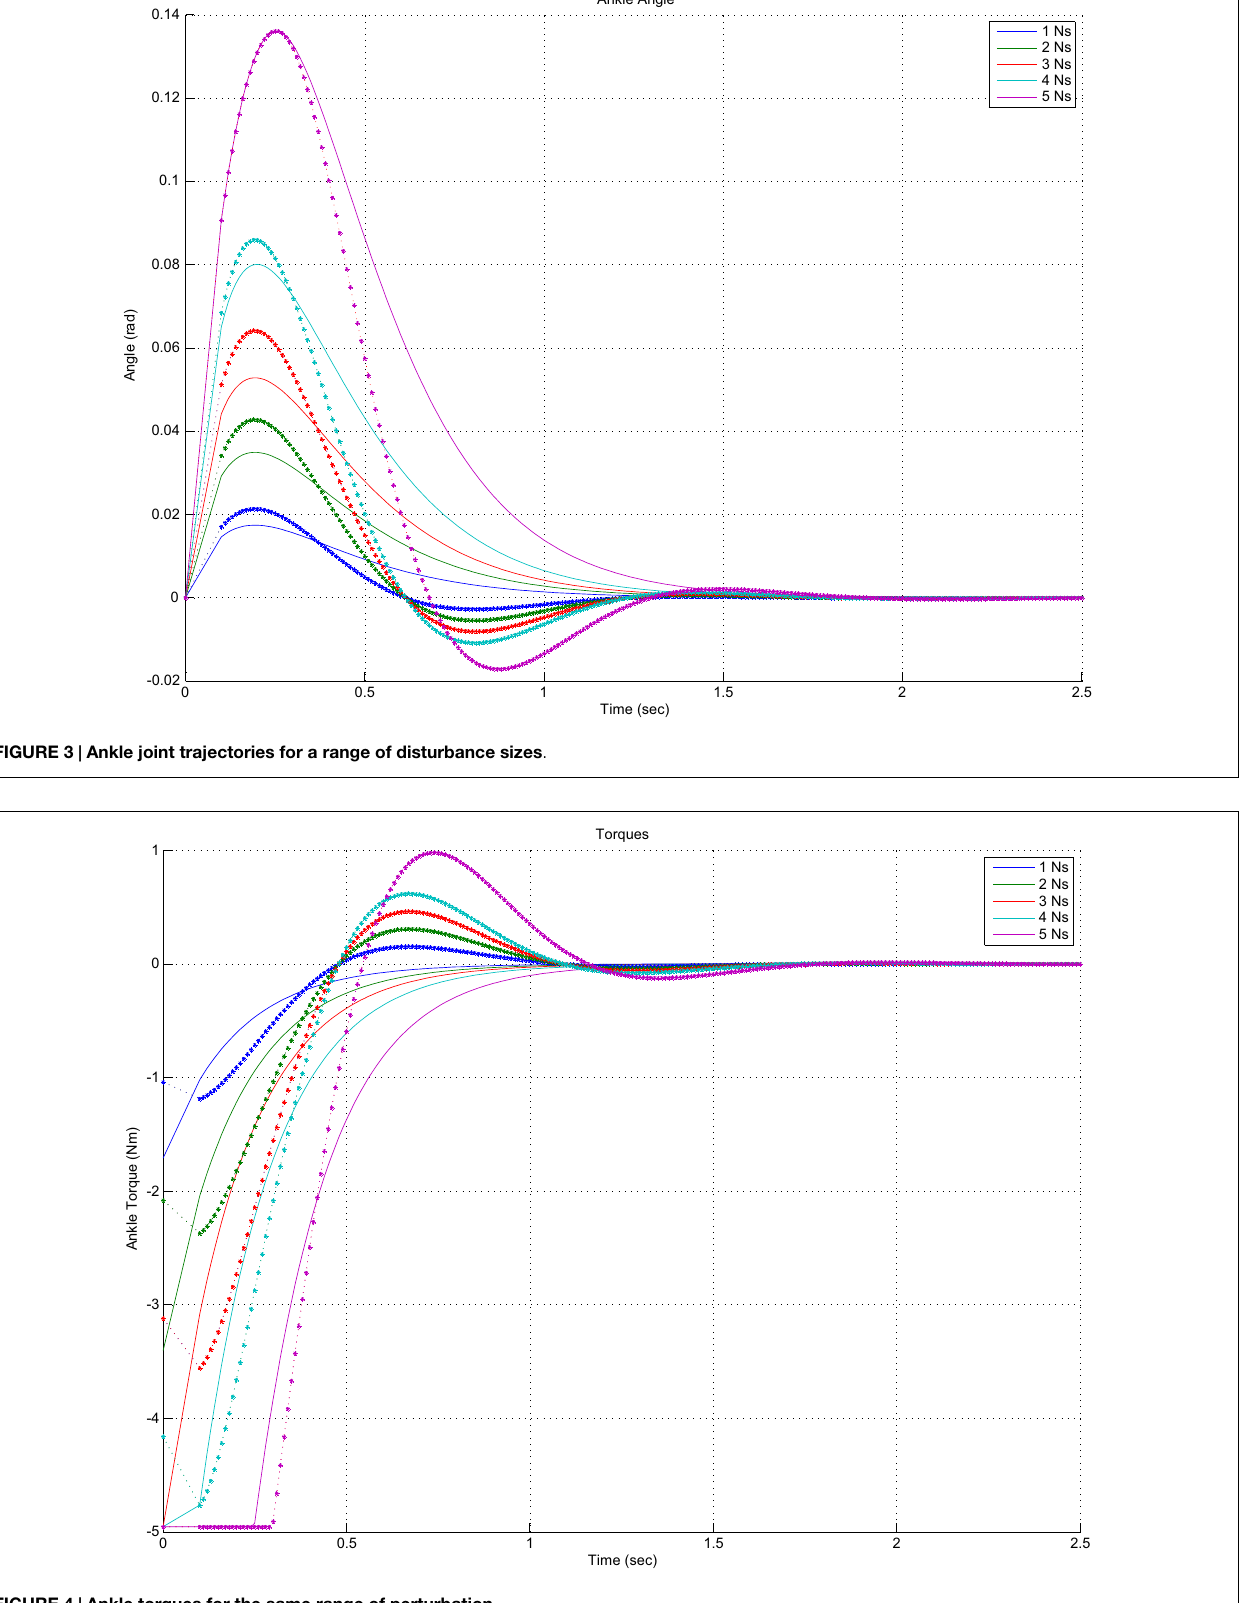
FIGURE 4 | Ankle torques for the same range of perturbation